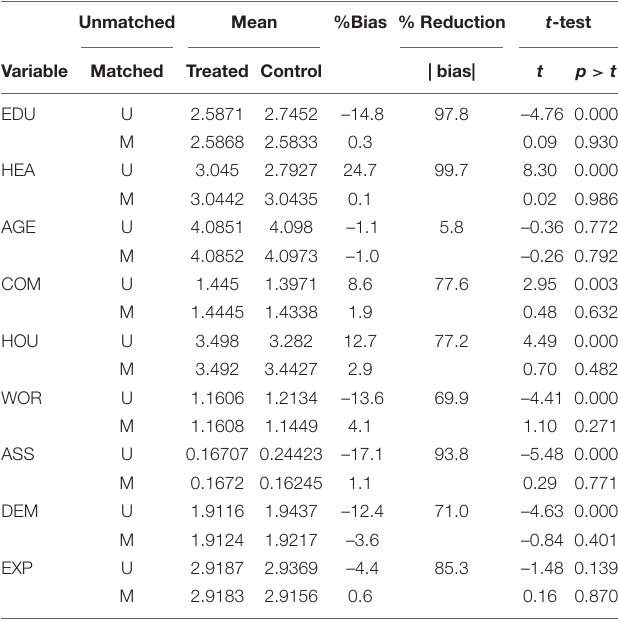
TABLE 4 | Balance test results of propensity score matching (PSM). Unmatched Mean %Bias %